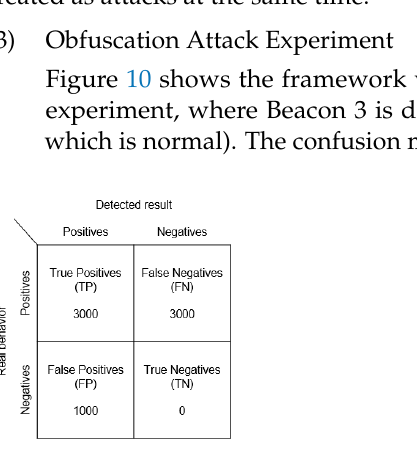
Figure 16. Obfuscation attack confusion matrix.